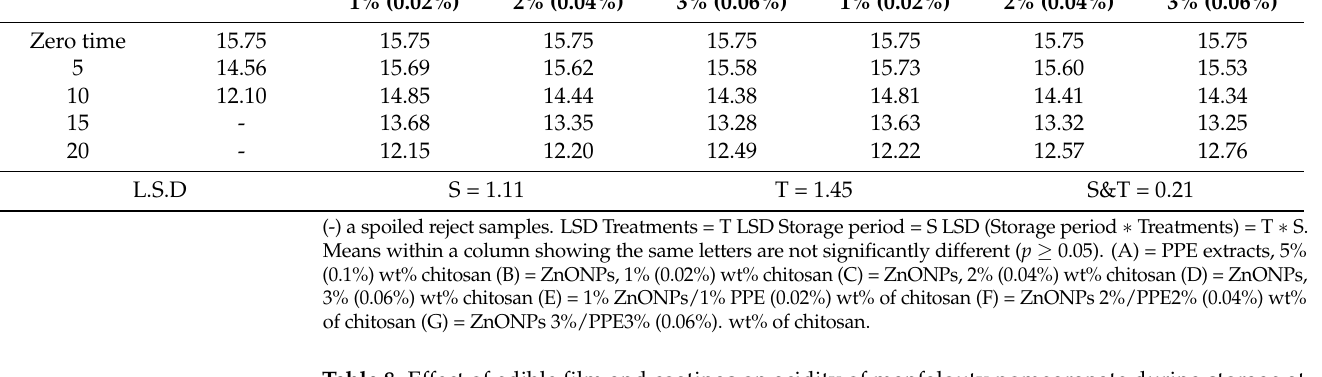
Table 8. Effect of edible film and coatings on acidity of manfalouty pomegranate during storage at 2 ◦